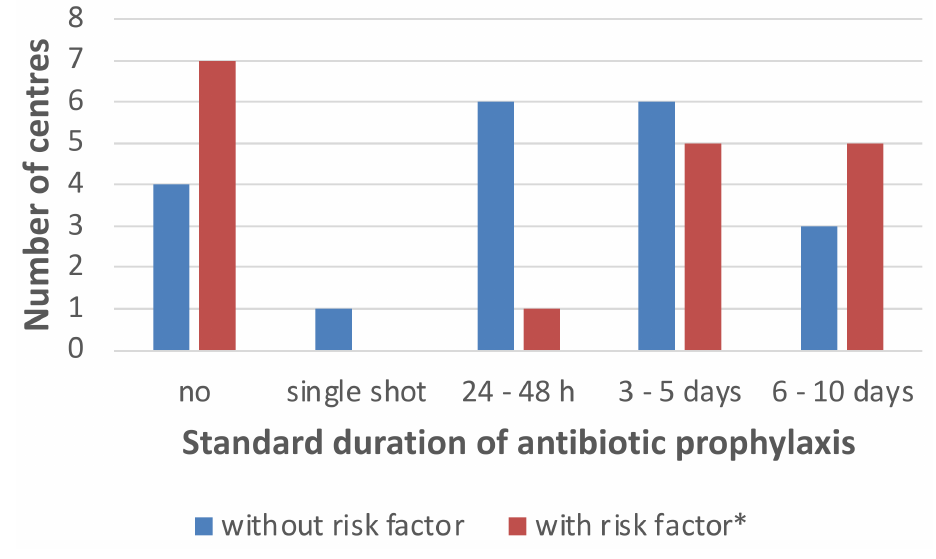
Figure 2. Duration of perioperative antibiotic prophylaxis, and according to additional risk factors in paediatric liver transplantation recipients. * Risk factors: defined by the treating physician/team, e.g., length of hospital stay, antibiotic treatment or intra-abdominal patch.